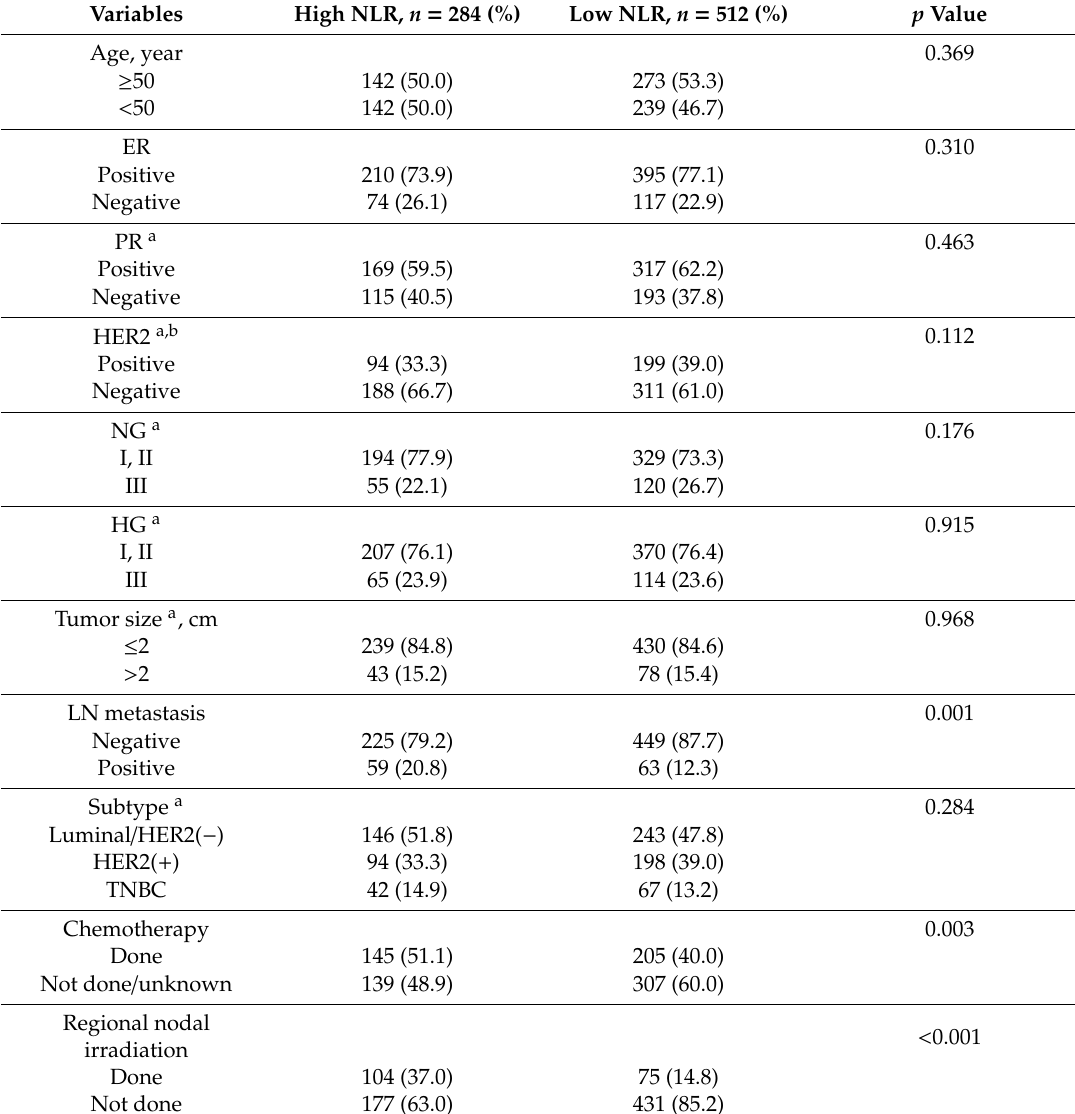
Table 1. Patients’ characteristics according to radiotherapy (RT) induced high and low neutrophil- to-lymphocyte ratio